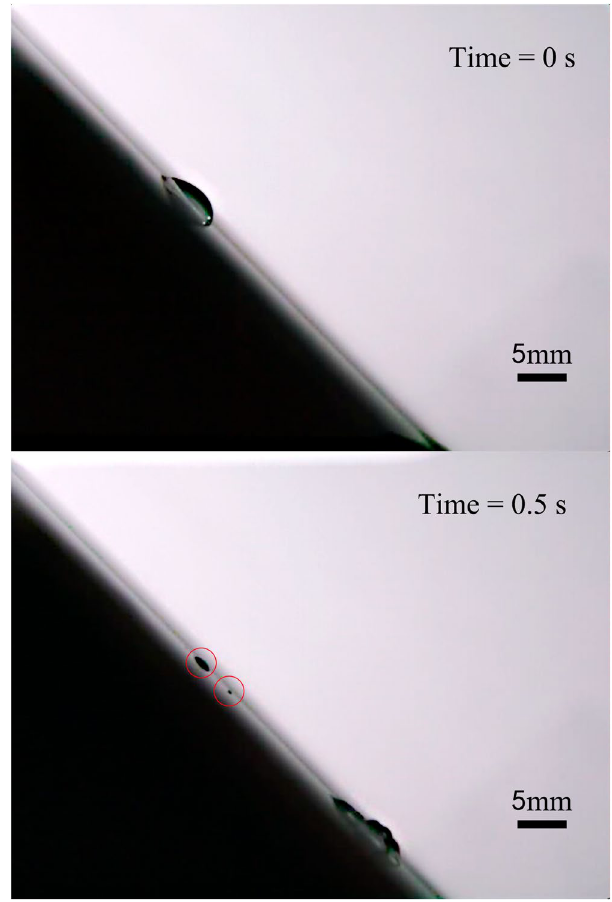
Figure 4. 10 μ l droplet movement induced by the 1 MHz Lamb waves at an inclination angle of 45°. The first pearl was dropped at the position of droplet’s advancing end of initial state, the second pearl followed immediately the first one within 0.02